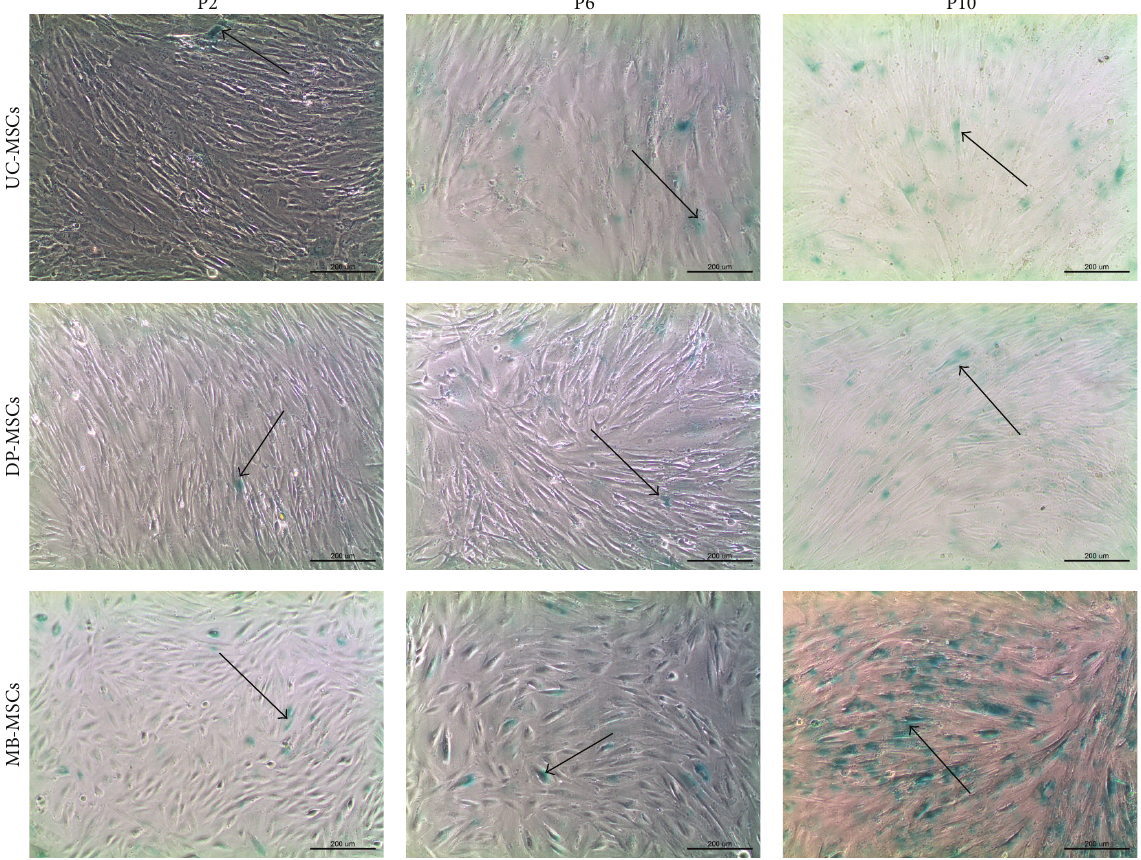
Figure 5: Senescence of UC-, DP-, and MB-MSCs. Senescence was assayed by SA- 𝛽 -gal activity with positive green staining (100x, arrow). UC-MSCs: umbilical cord mesenchymal stem cells; DP-MSCs: dental pulp mesenchymal stem cells; MB-MSCs: menstrual blood mesenchymal stem cells; P: